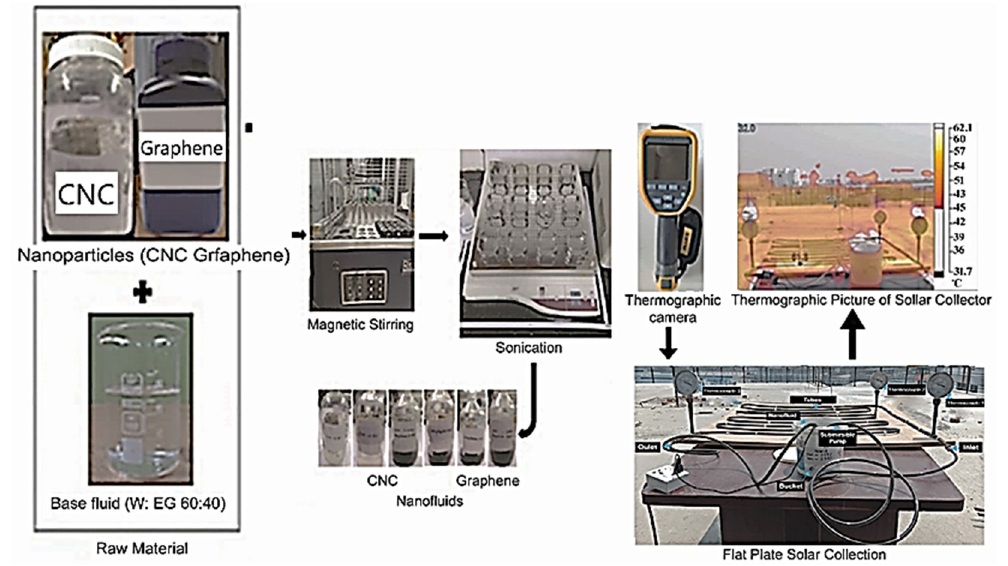
Figure 8. Entire process flow chart of the experiment.